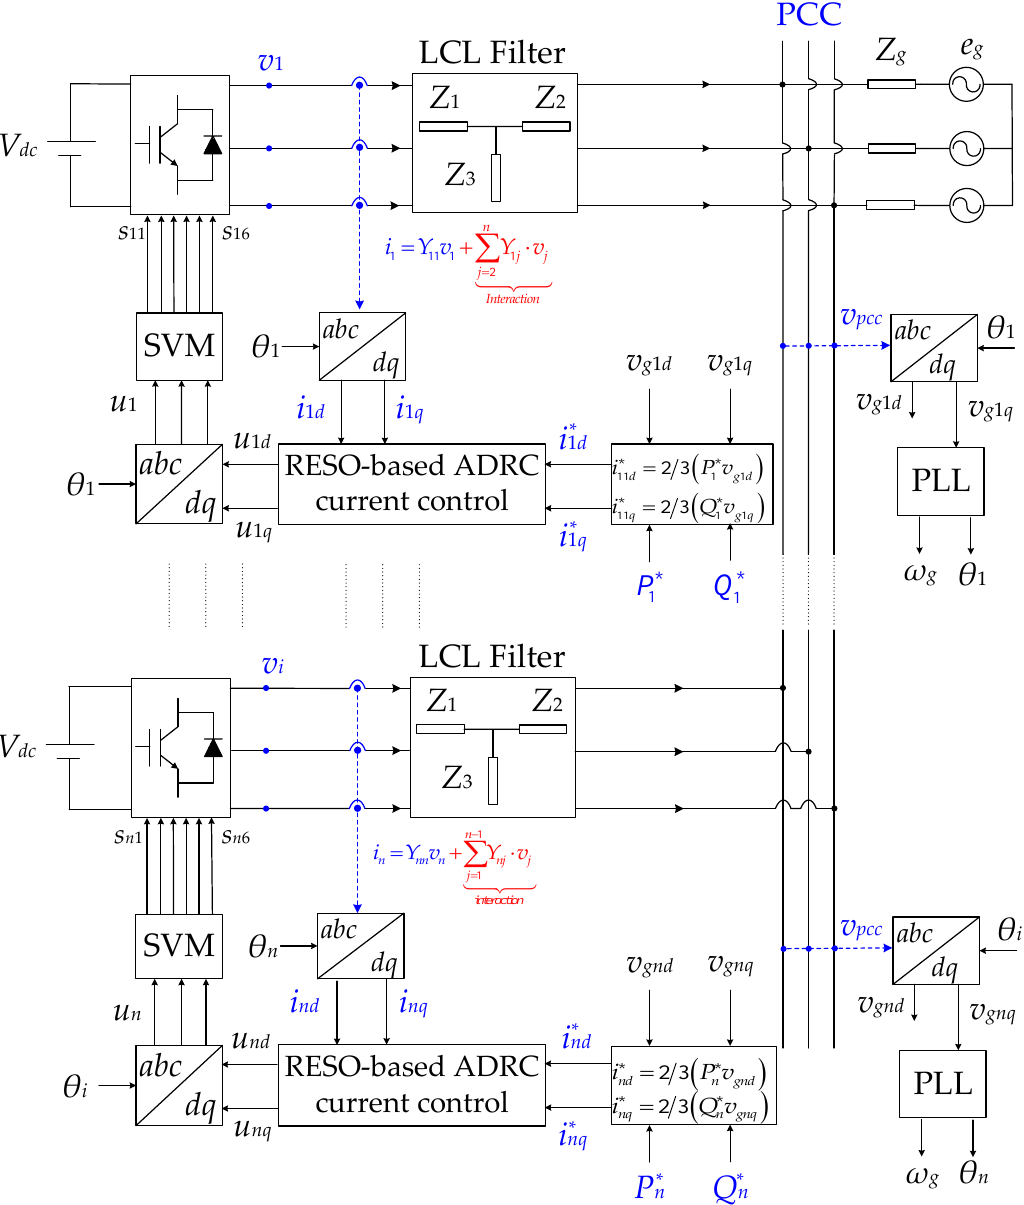
Figure 2. Overall system with the proposed reduced-order extended state observer (RESO)-based active disturbance rejection control (ADRC) current control scheme.